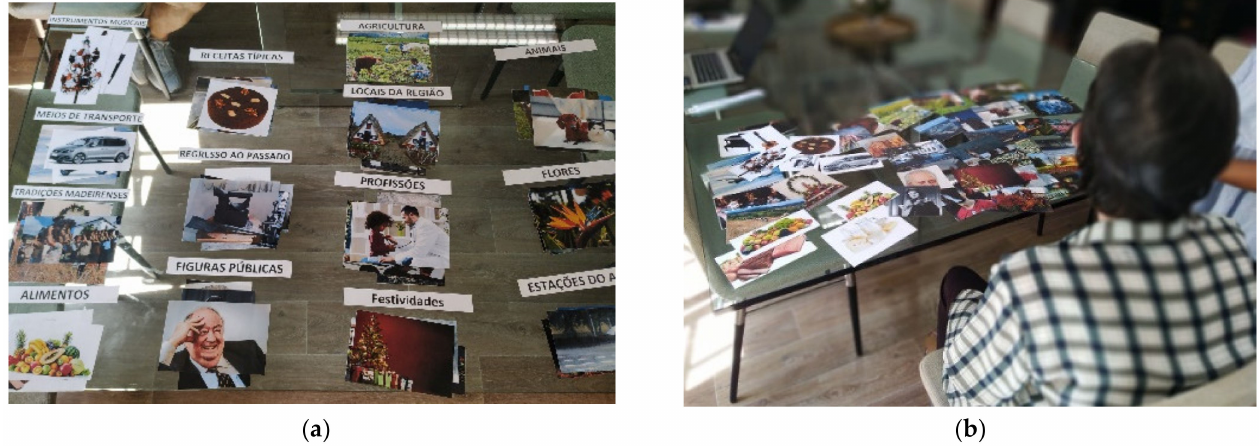
Figure 3. ( a ) Presentation of the most referred themes to IwD, using verbal and visual information; ( b ) researcher went through the images together with IwD to assure that they all assigned them the right